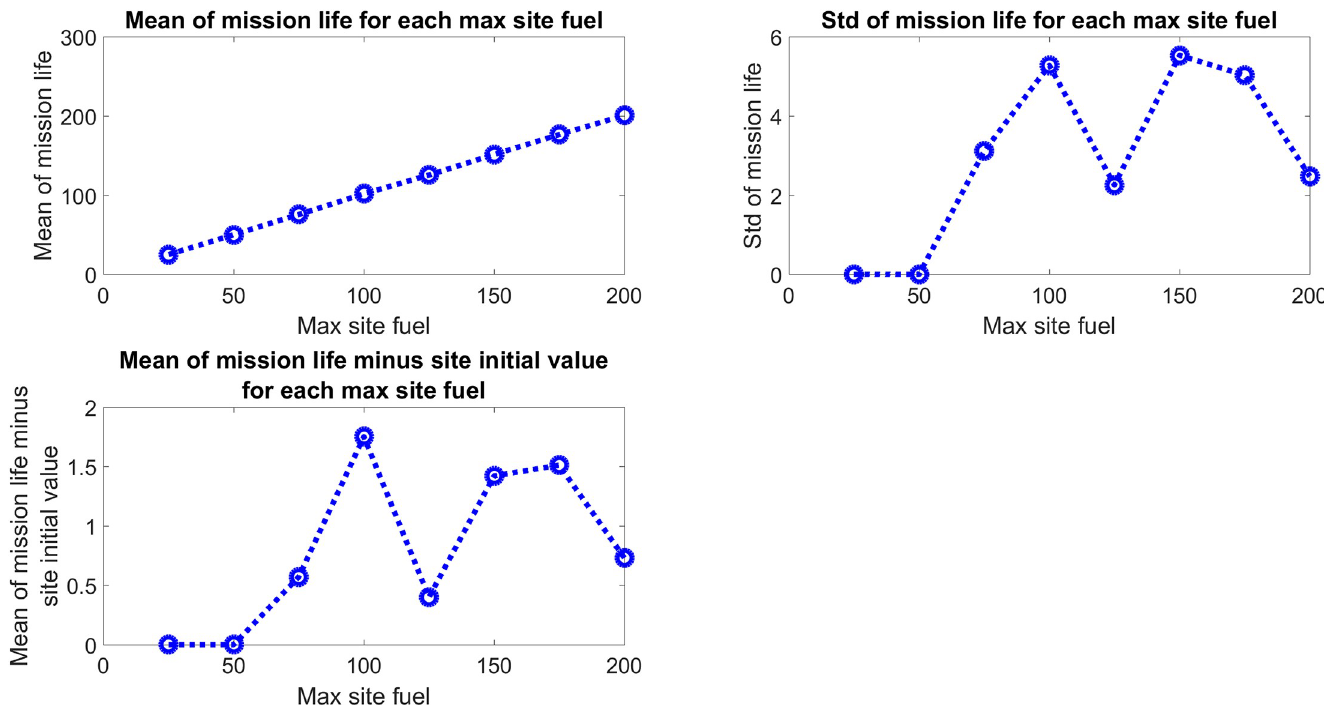
Fig 15. Mission life statistics. The mean mission life increases with the maximum and initial site fuel value, and the standard deviation of mission lives also generally increases with maximum and initial site fuel value. To show the deviation from a purely linear increase in mission life, the bottom left plot shows the mean mission life with the minimum possible mission life subtracted off. This result shows the mission-life extending effect due to refueling by the assets.